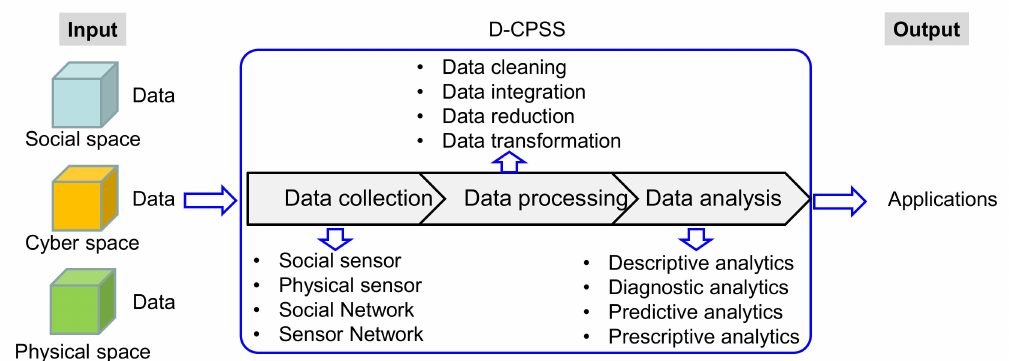
Figure 3. A general model of D-CPSS from the perspective of data